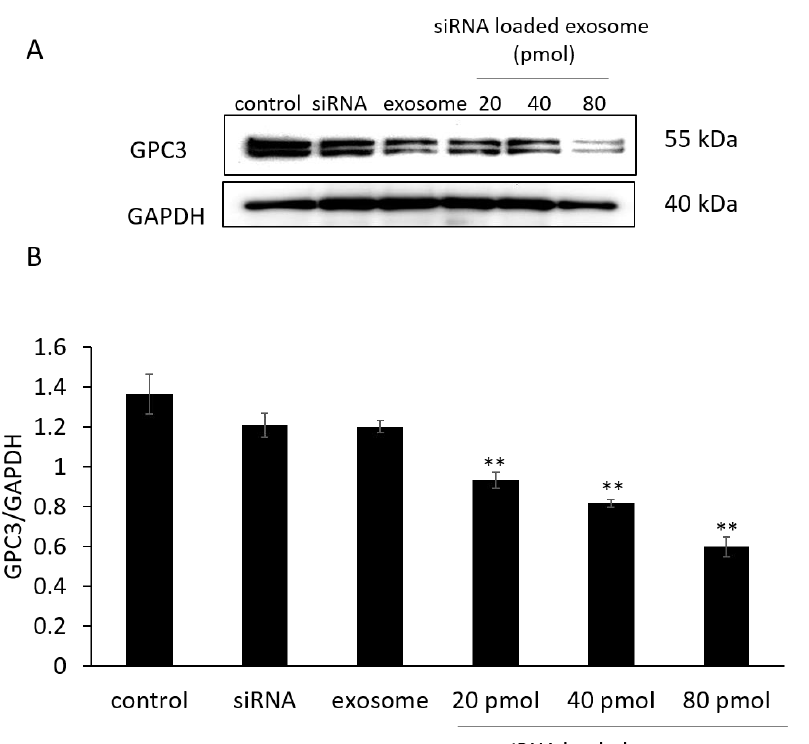
Figure 2. ( A ) Blotting images of GPC3 levels in B16/BL6 cells treated with siRNA-loaded exosomes at various siRNA concentrations and ( B ) its western blotting analysis. Data represent the mean ± SD of three independent experiments; ** p < 0.01 versus the control group (Bonferroni test/ANOVA).